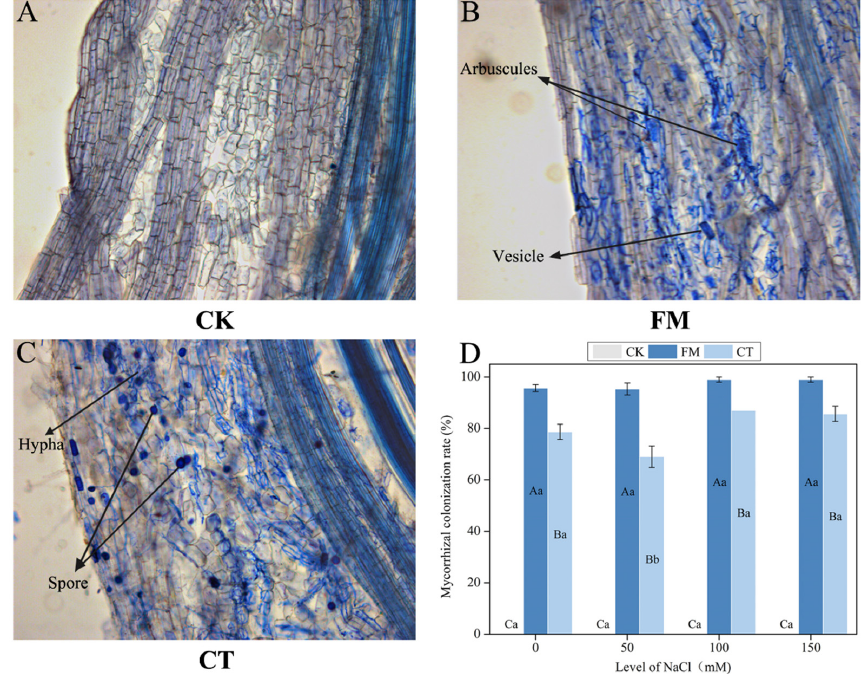
Figure 1. Variations in mycorrhizal colonization status between treatments. ( A ) mycorrhizal colonization statu of CK treatment; ( B ) mycorrhizal colonization statu of FM treatment; ( C ) mycorrhizal colonization statu of CT treatment; ( D ) mycorrhizal colonization rate of different treatments. Different uppercase letters indicate significant differences between various inoculation treatments under same salt levels ( p < 0.05). Different lowercase letters indicate significant differences between various salt levels under inoculation treatments ( p < 0.05). Error bars refer to standard errors.